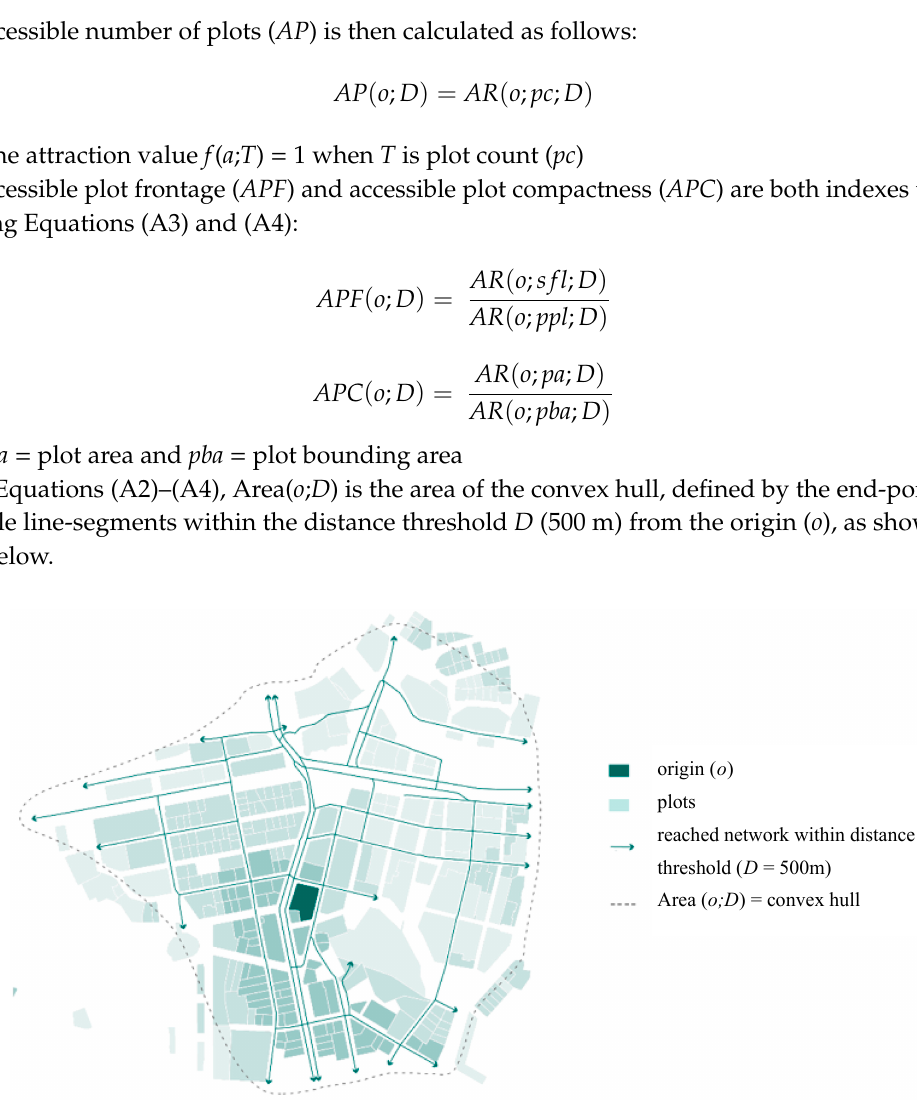
Figure A1. Definition of the convex hull used in PST for calculating Area ( o ; D Figure A. Definition of the convex hull used in PST for calculating Area ( o ; D ).